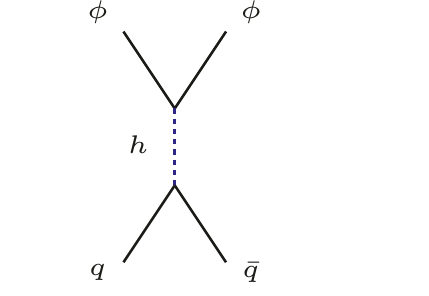
Figure 2 . The DM-quark direct detection scattering cross section is shown at the leading order in perturbation